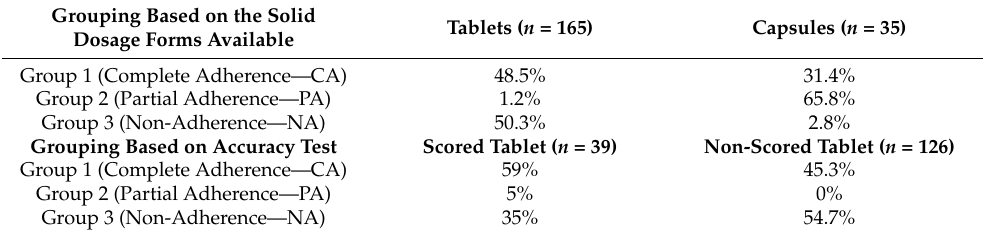
Table 1. Summary of the accuracy test results.